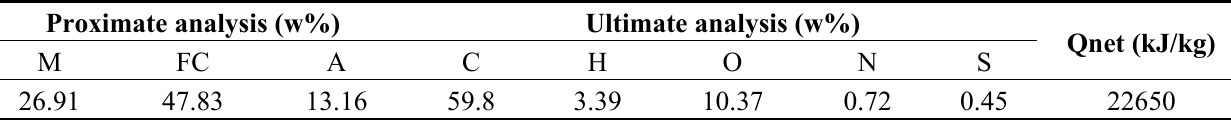
Table 4. Proximate analysis and ultimate analysis of coal used in the